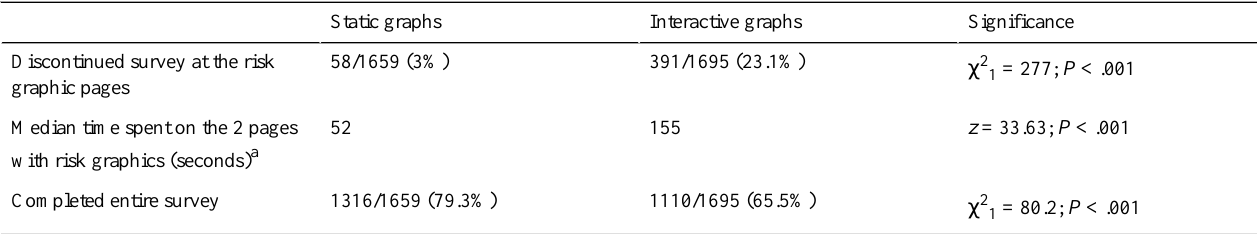
Table 3. Survey completion times rates, by graphic type